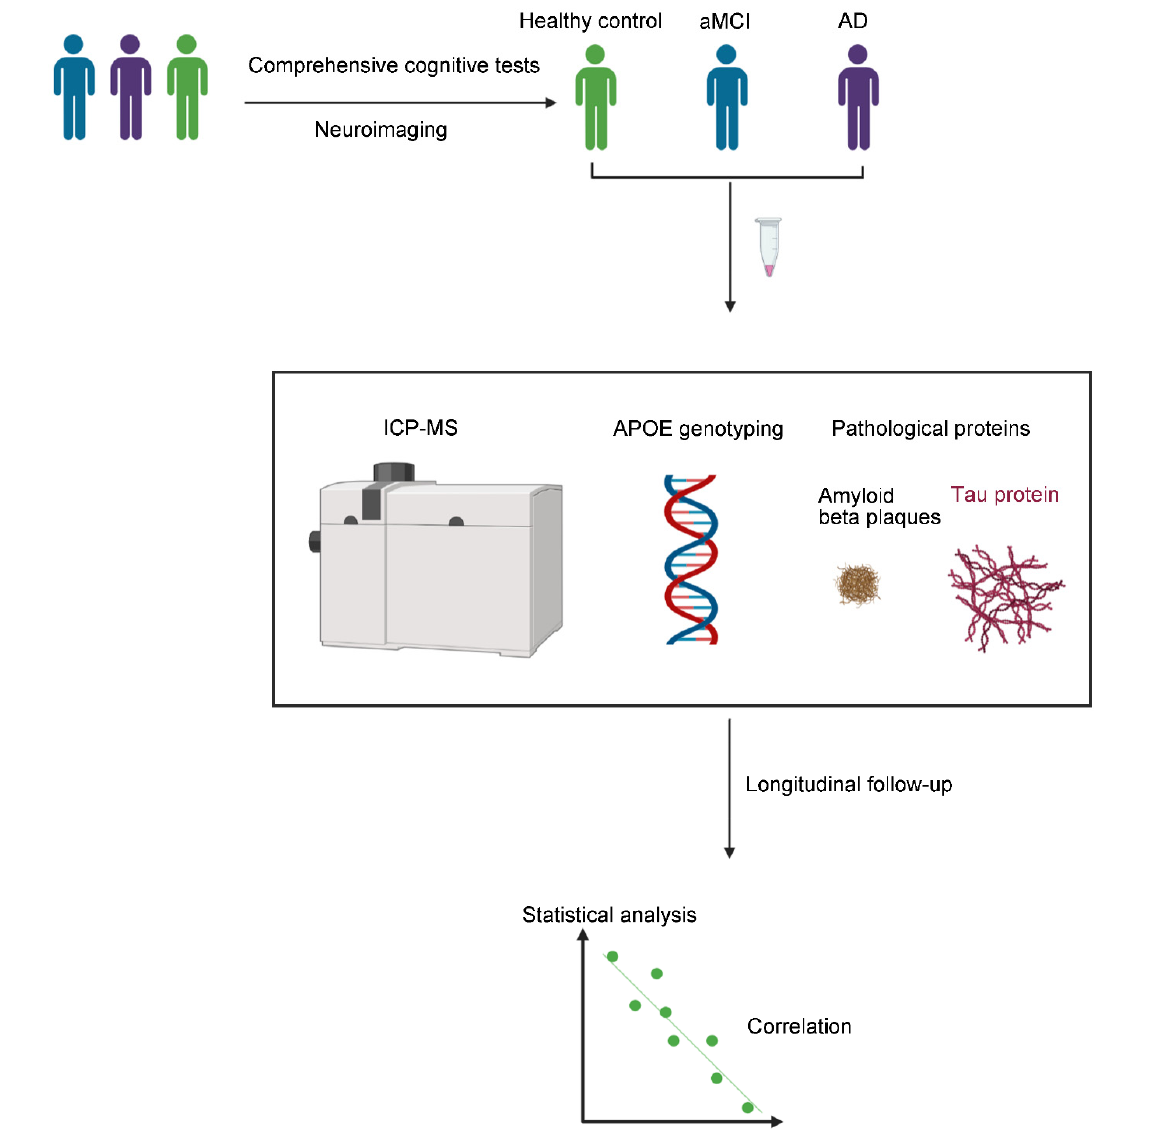
Figure 1. Schematic diagram of the study methodology and procedures. We recruited participants from the memory clinic at the Tri-Service General Hospital. After comprehensive cognitive tests and neuroimaging examination, the participants were divided into three groups (healthy control, aMCI, and AD). Blood samples were collected. ICP-MS, single nucleotide polymorphism (SNP) arrays, and immunomagnetic reduction (IMR) assays were used to evaluate plasma metal levels, APOE genotypes, and plasma pathological protein levels, respectively. In addition, statistical analyses were used to assess the correlation between metal levels and cognitive decline in patients with aMCI and AD. aMCI, amnestic mild cognitive impairment; AD, Alzheimer’s disease; ICP-MS, inductively coupled plasma-mass spectrometry; APOE, apolipoprotein